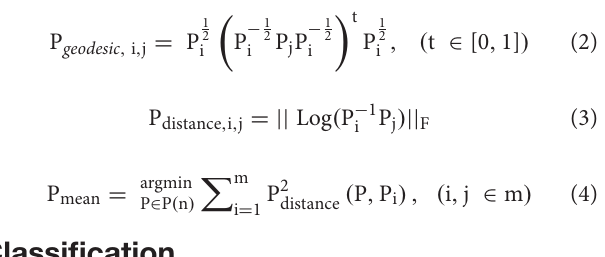
mean square processing was performed and a 1-Hz low-pass filter was used for smoothing before calculation of the